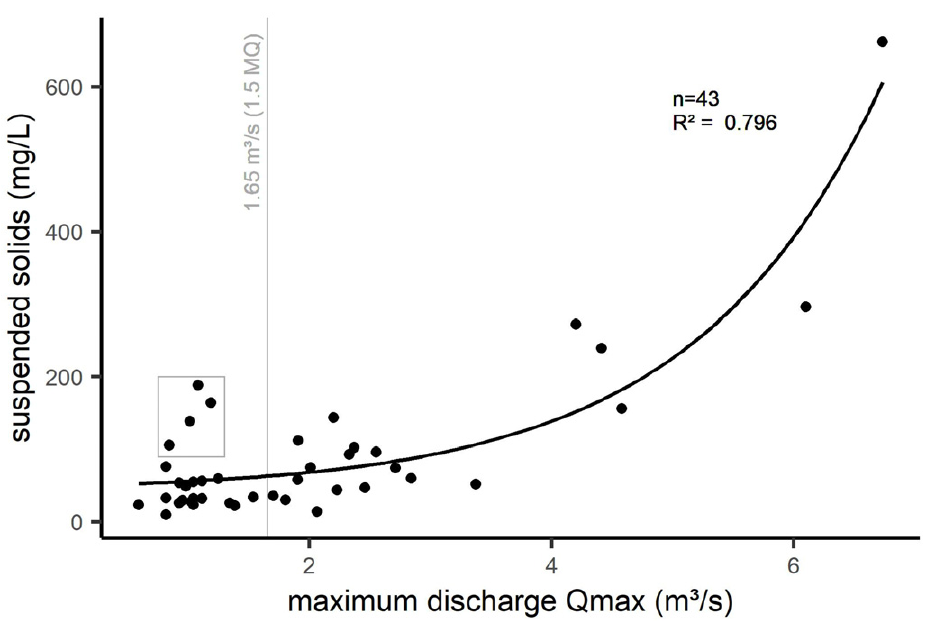
Figure 3. Rating curve of the Kraichbach with the threshold of 1.65 m 3 s − 1 for the dry weather flow. Outliers are marked with a